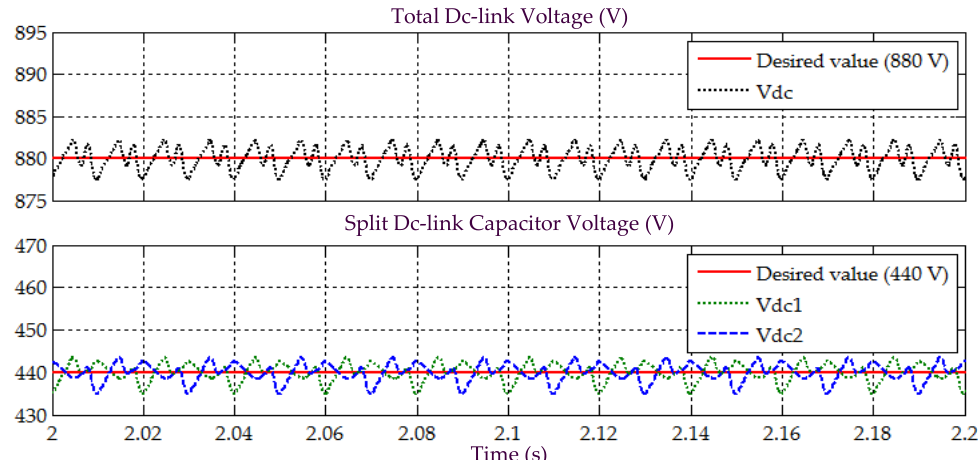
Figure 22. Simulation result obtained under Scenario D for Load 1, showing the total dc-link voltage V dc , and voltages across split dc-link capacitors V dc 1 and V dc 2 , demonstrated by SAPF while applying the proposed STF- dq 0 technique. Energies 2018 , 11 , x FOR PEER REVIEW